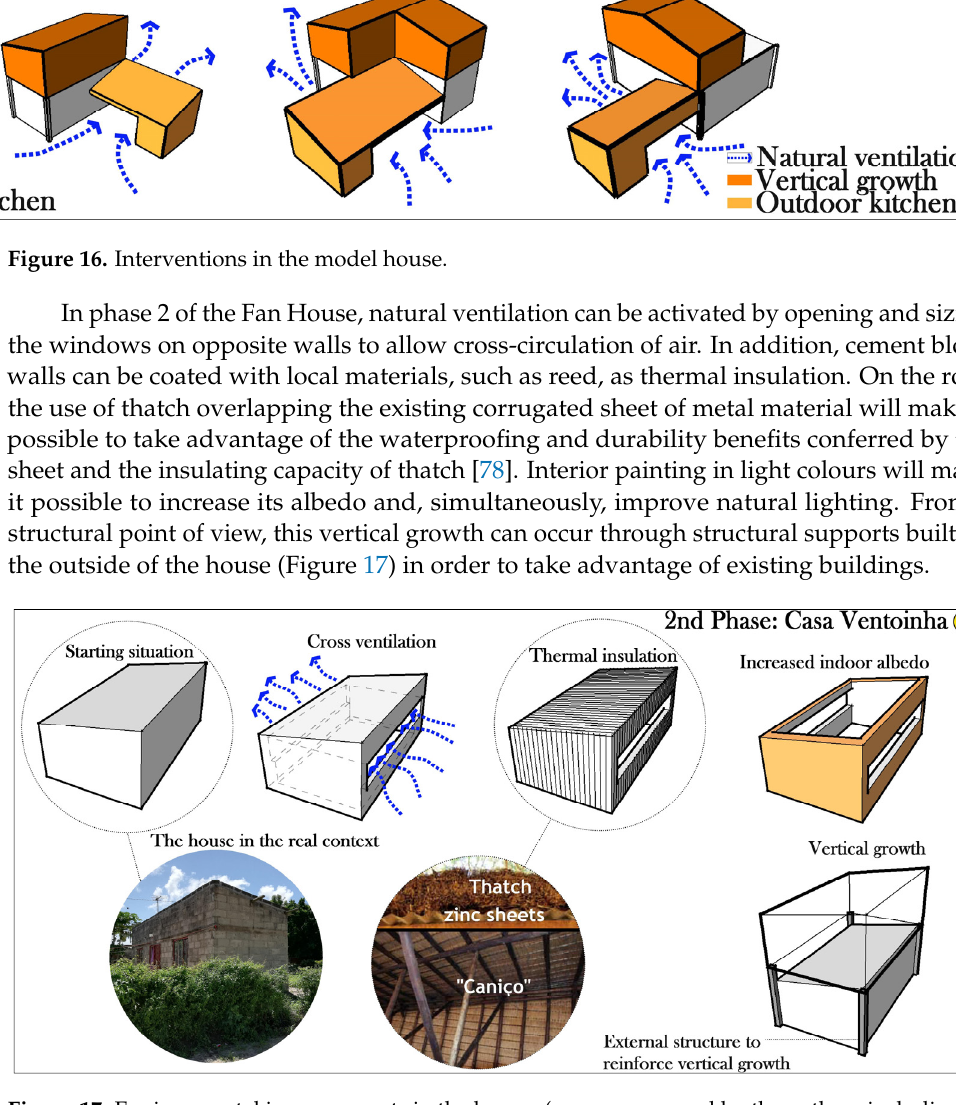
Figure 17. Environmental improvements in the house. (source: prepared by the authors including an image from Guedes [78]).